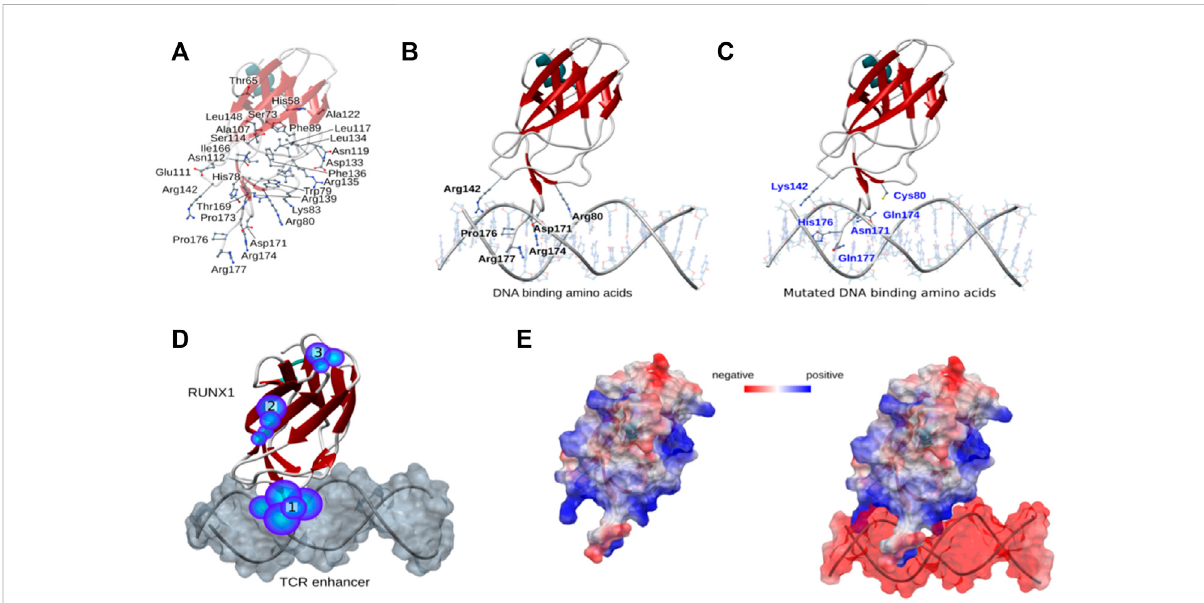
FIGURE 2 Structural mapping of RUNX1 cancer-associated mutations. (A) Mutation sites within the RUNX1 protein structure, showing all 46 recurrent mutations across the DNA binding domain. (B,C) Mutation positions associated with DNA binding; wild type amino acids are highlighted with their labels re fl ecting the uniprot numbering scheme (uniprot ID: Q01196). (D) Predicted active pockets for drug binding within the RUNX1-ETS DNA complex. Highlighted numbers show three major pockets for drug binding. (E) Electrostatics of RUNX1 and RUNX1 with DNA. Blue indicates highly electropositive surfaces, while red color shows signi fi cantly electronegative surfaces for the